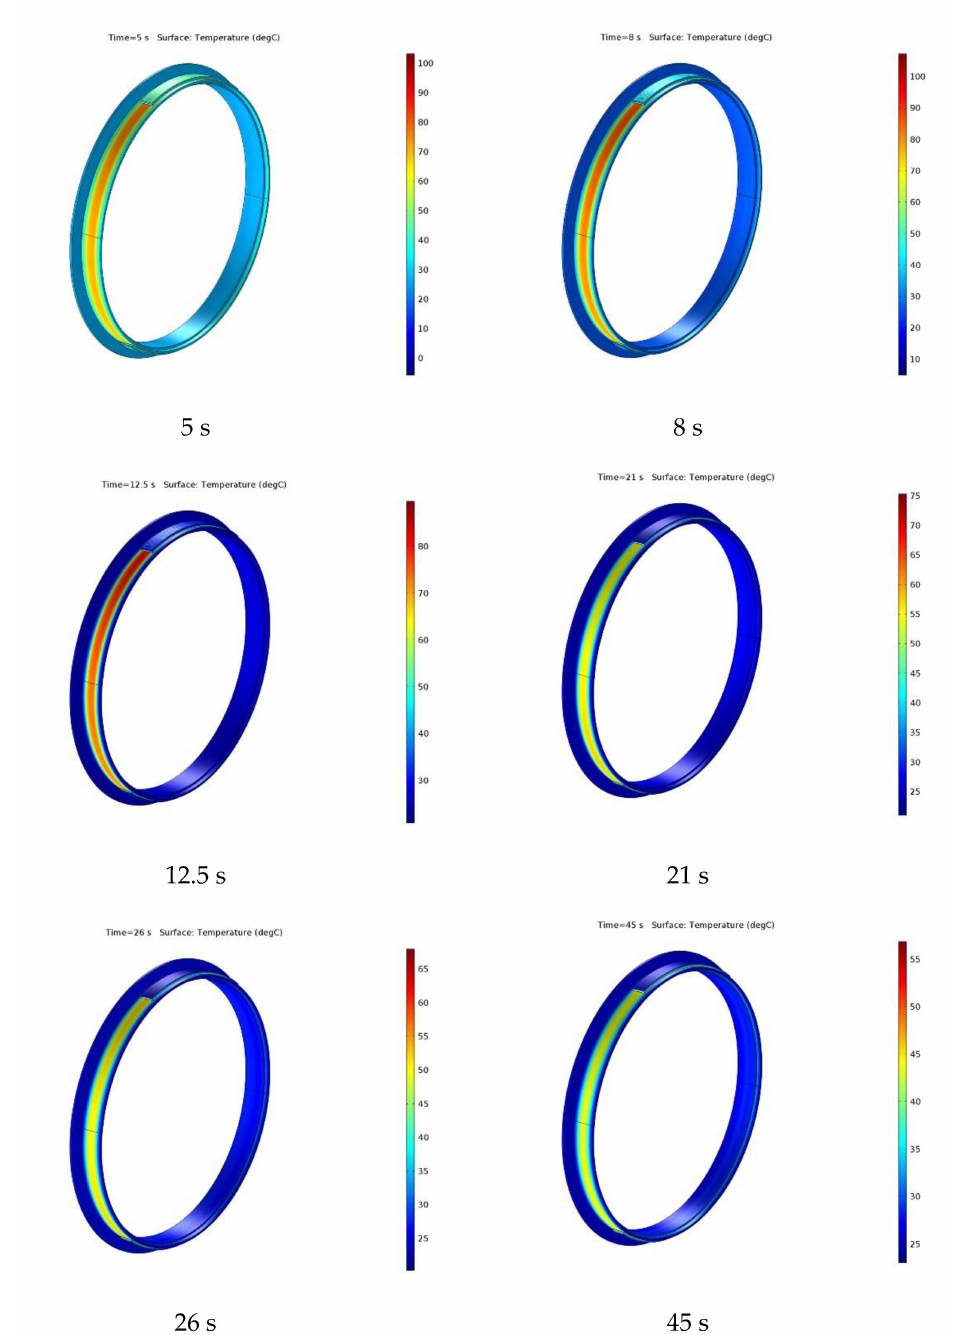
Figure 8. The drum lining surface temperature at different times during braking. The next specific data set introduced is of type Cut Line 3D . This line is drawn transver- sally through the 3D geometries of the drum and brake shoe. The temperature variation in time along the cut line during the maneuver braking is shown in Figure 9. It is visible that the highest temperatures appear towards the middle of the drum and brake couple section, and a cooling takes place in time. Figure 10 shows the actual temperature along the cut line at specific moments of time (5 s, 8 s, 12.5 s, 21 s, 26 s, and 45